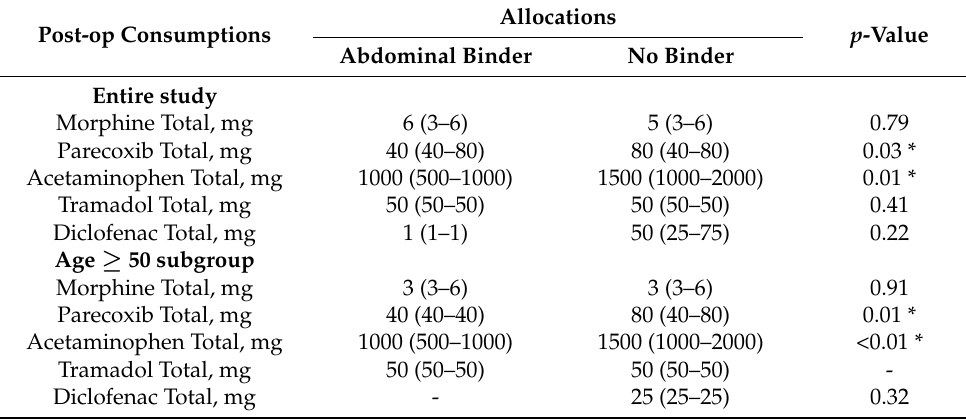
Table 3. Postoperative pain medication